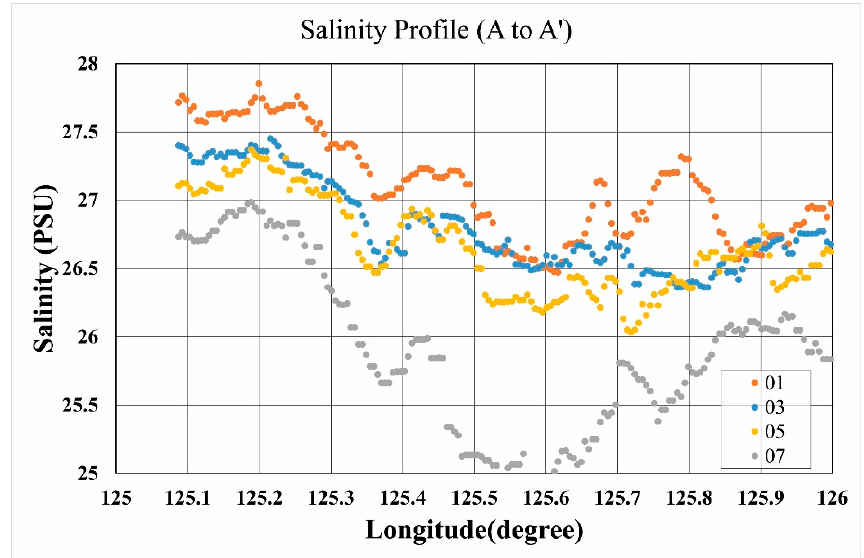
Figure 5. The GOCI-derived SSS values along line AA' in Figure 4 at 10:30, 12:30, 14:30, and 16:30 local time.